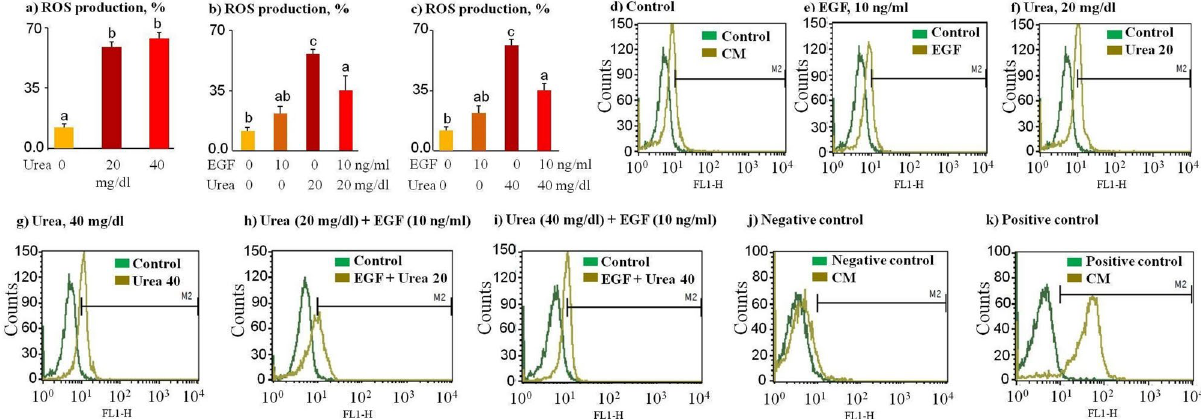
Figure 3. ( a – c ) ROS production by sperm in the presence of EGF and urea. Bovine sperm cells were pre- incubated for 30 min with various levels of urea (0, 20, and 40 mg/dl) in the presence or absence of EGF (10 ng/ ml). ( d – i ) Good staining has been obtained, which has shown a marked increase in DCF fluorescence (FL-1) in sperm cells treated compared to control sperm cells, suggesting an increase in ROS production. ( j – k ) An aliquot of the unstained culture medium (TALP) was treated for 15 min with 10% H 2 O 2 (positive control) or 1 mM N-acetyl-l-cysteine (ROS Inhibitor) as a negative control of the technique. The data was analyzed using the Tukey test (n = 3). CM culture medium, Control sperm incubation without EGF or urea, EGF sperm incubation with 10 ng/ml EGF, Urea 20 sperm incubation with 20 mg/dl urea, Urea 40 sperm incubation with 40 mg/dl urea, EGF + Urea 20 sperm incubation with 10 ng/ml EGF and 20 mg/dl urea, EGF + Urea 40 sperm incubation with 10 ng/ml EGF and 40 mg/dl urea. Numerical values are presented as mean ± S.E.M. Different letters (a, b, c) indicate significant differences between treatments at P <